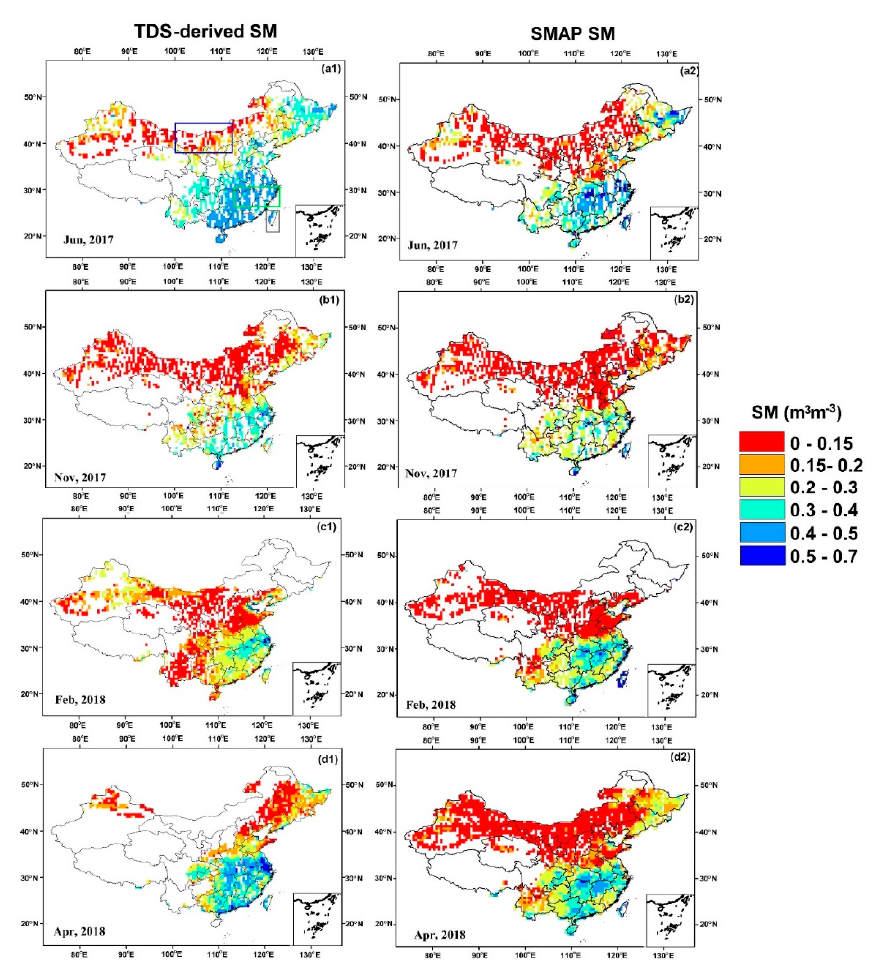
Figure 6. Comparisons of the SM derived from TDS-1 and the SMAP SM. ( a 1– a 2) June 2017, ( b 1– b 2)